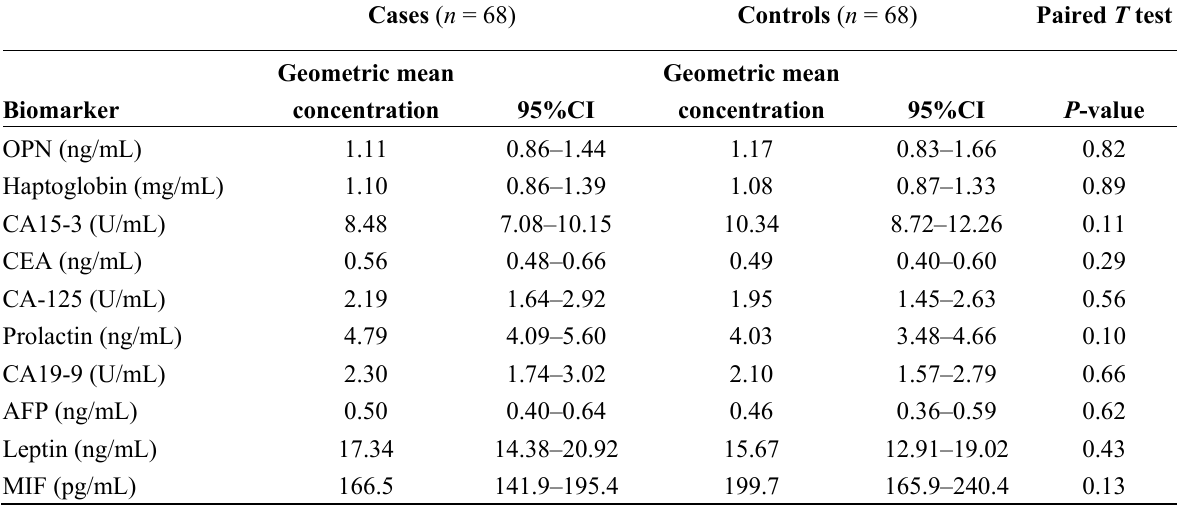
Table 4. Serum concentrations of all measured proteins in the pre-diagnostic breast cancer- and healthy control